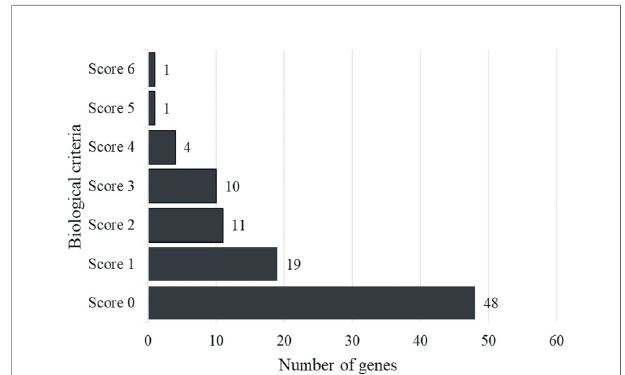
FIGURE 2 | Histogram distribution of gene score. The fi gure showed that genes with a score of 0 were 48, while those with a score of 1 were 19, and there were 27 genes with total scores ≥ 2 were described as “ Biological AD risk genes